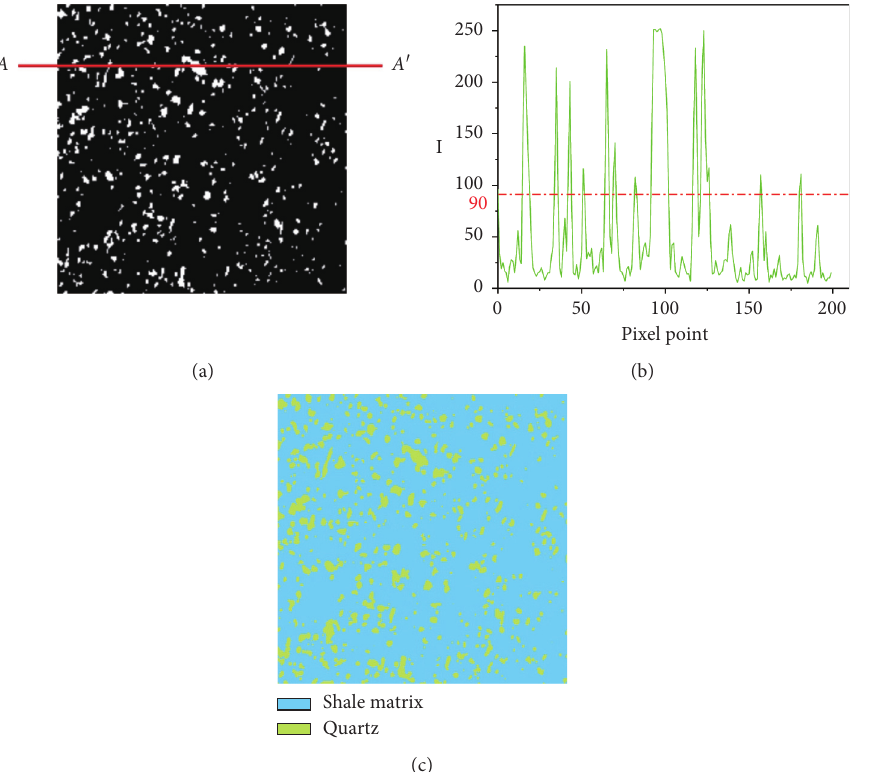
Figure 7: Scanning variation of shale digital